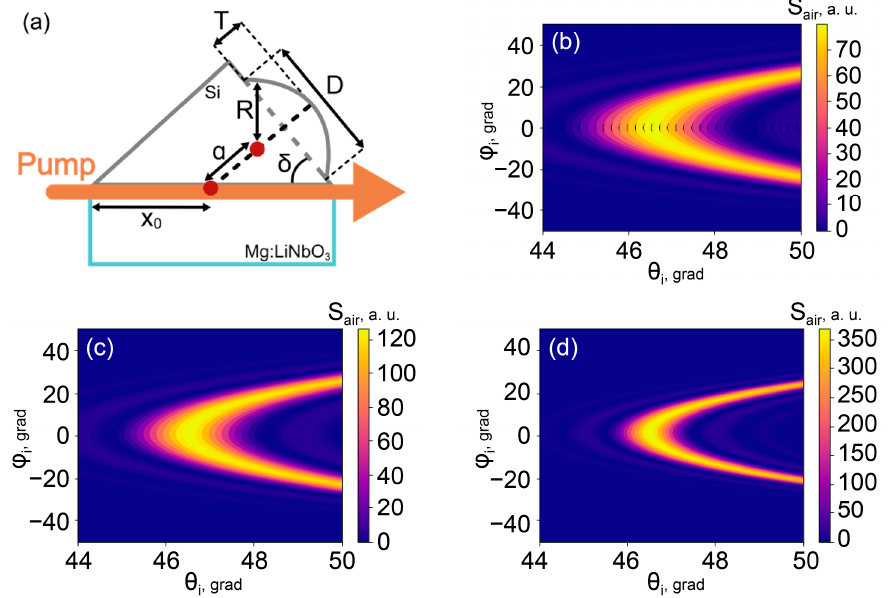
≡ζ ; ( b – d ) calculated angular